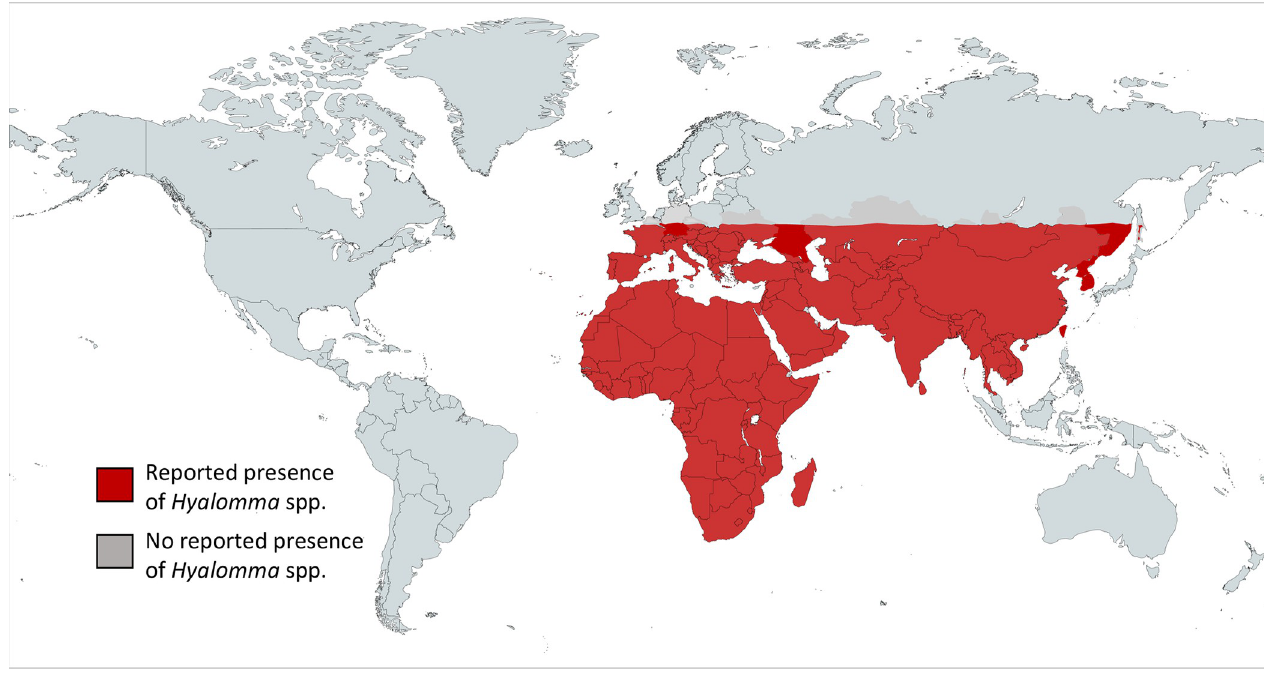
Fig 1. Global geographic distribution of Hyalomma spp. ticks. Created with mapchart.net.